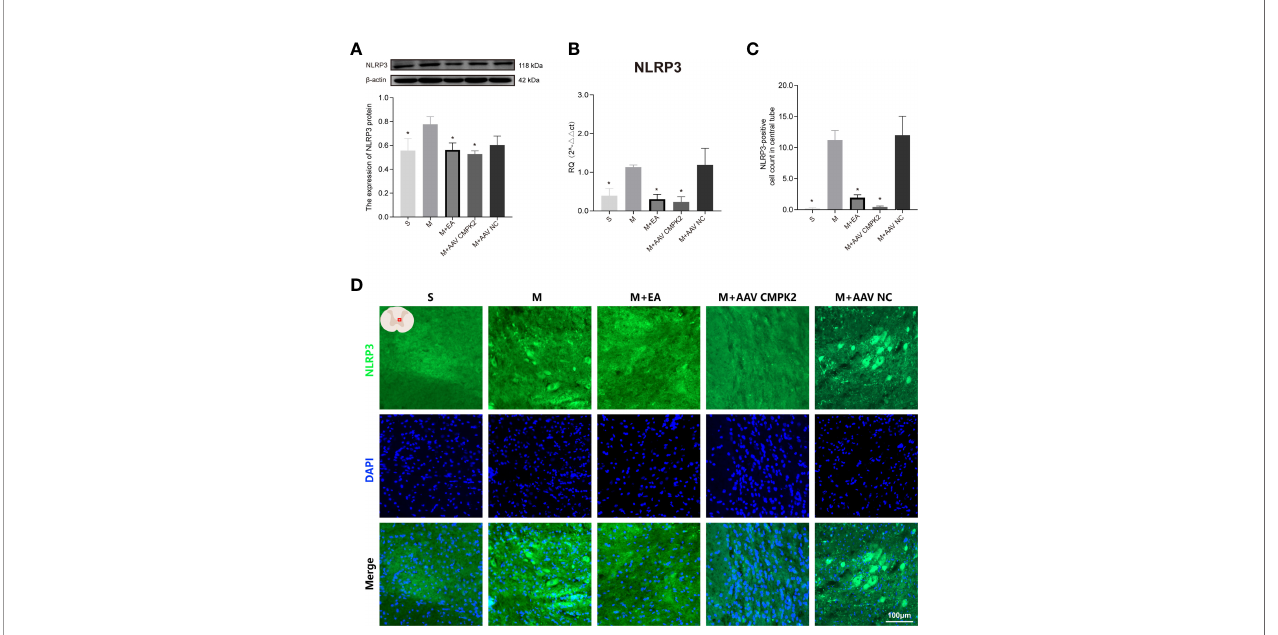
FIGURE 9 | Effects of CMPK2 knockdown on activation of the NLRP3 in fl ammasome in rat spinal cord. (A) Western blotting analysis of NLRP3 expression in spinal cords of rats in the Sham group, Model, M+EA, M+AAV CMPK2, and M+AAV NC groups. A representative Western blotting and semiquantitative analysis of NLRP3 protein levels are shown. N = 5 rats/group. *p < 0.05 compared with the Model group; one-way anOVA was used for comparison. (B) Quantitative PCR analysis of NLRP3 gene expression in the spinal cords of rats in the Sham, Model, M+EA, M+AAV CMPK2, and M+AAV NC groups. N = 5 rats in each group. *p < 0.05 compared with the model group; one-way anOVA was used for comparison. (C) Quantitative analysis of NLRP3-positive cells. *p < 0.05 compared with the model group; one-way anOVA was used for comparison. N = 5 rats/group. (D) The expression of NLRP3 in the spinal cords of rats in the Sham, Model, M+EA, M+AAV CMPK2, and M+AAV NC groups were detected using IF. The number of CMPK2-positive cells (green fl uorescence) 3 days after SCI was labeled by immuno fl uorescence, and the areas with positive NLRP3 staining are shown in green. All data are expressed as the mean ± SEM. IF, immuno fl uorescence; SCI, spinal cord injury.